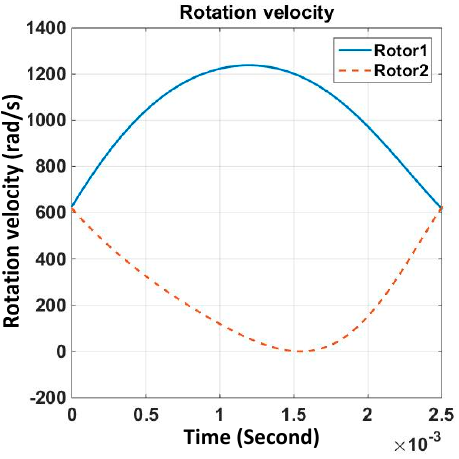
Figure 4. Angular velocity of the two rotors.